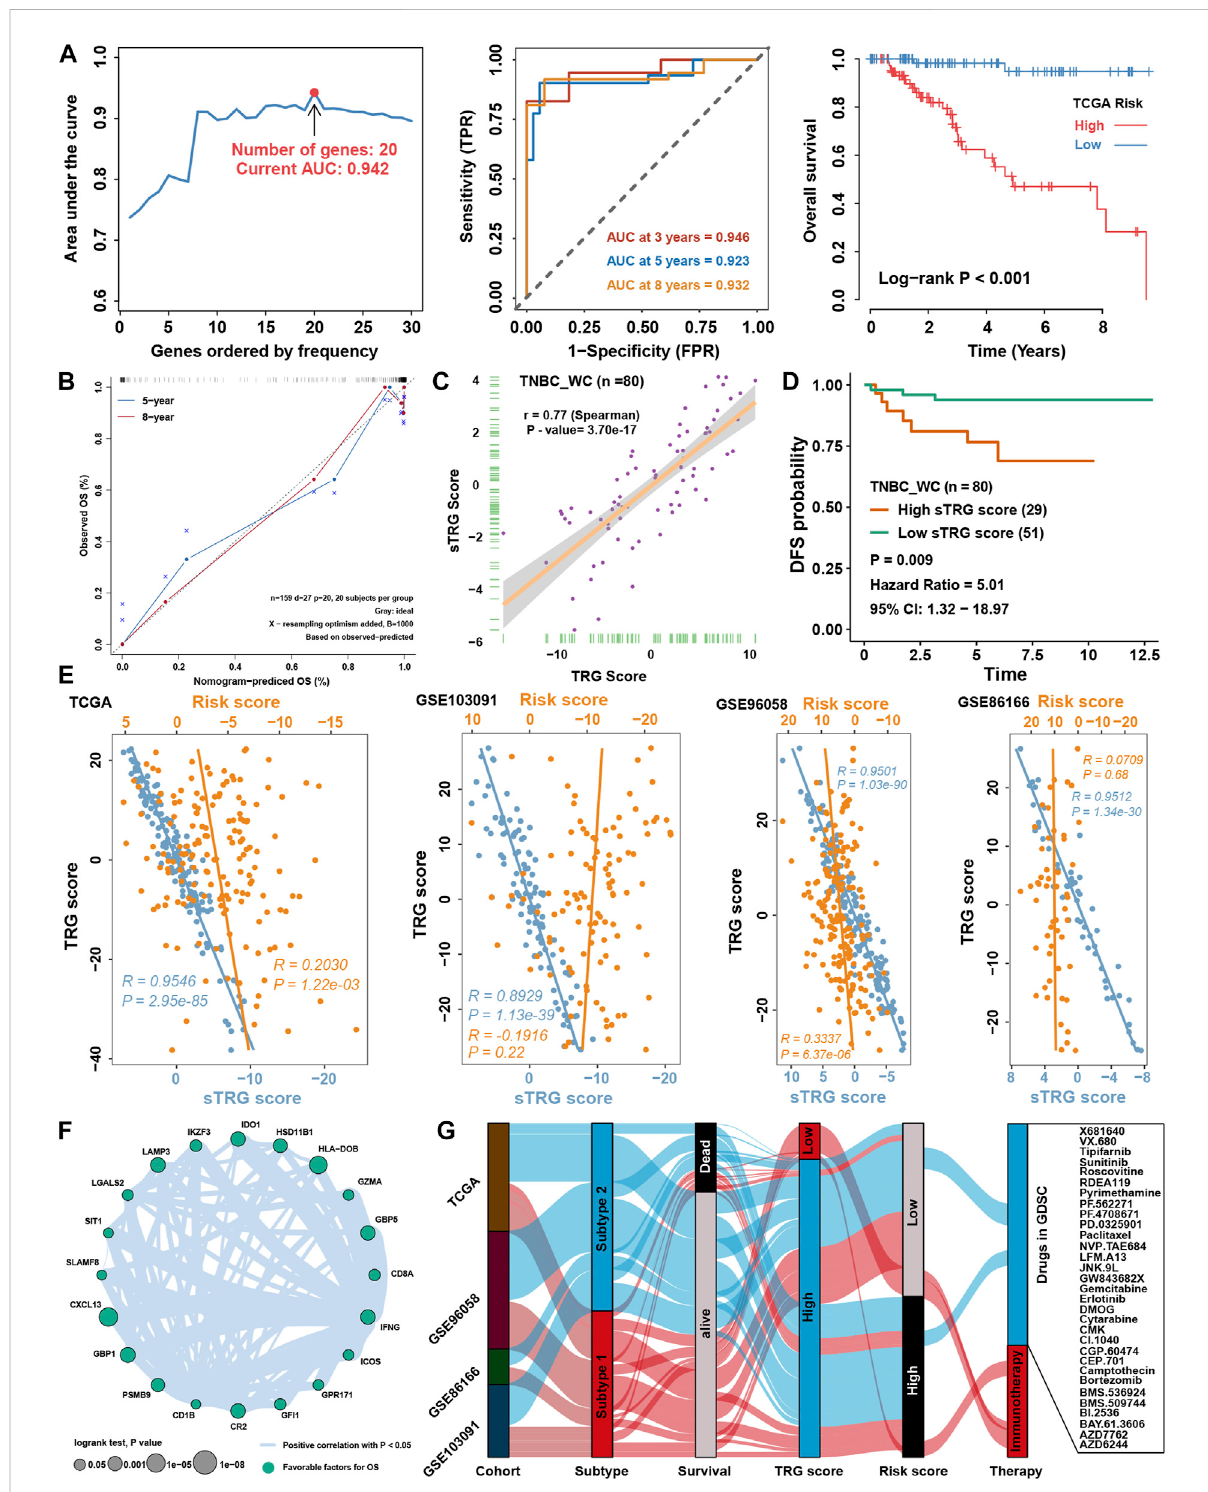
FIGURE 9 Prognostic signature construction and simpli fi cation of the TRG score. (A) Iteration LASSO constructed a prognostic signature with 20 genes. The AUC for 5 years was 0.942, and the survival curve for the risk group is shown in the right panel. (B) Calibration curve for the comprehensive survival nomogram model in theTCGA TNBC cohort. The dashed diagonal line represents the ideal nomogram, and theblue and red lines represent the 5- and 8-year observed nomograms, respectively. (C) Correlation between the sTRG score and TRG score in the TNBC_WC cohort. (D) SurvivalanalysisforthesTRGscoreintheTNBC_WCcohort. (E) CorrelationanalysisbetweentheTRGscoreandsimpli fi edTRG(sTRG)scoreandrisk score infour TNBCcohorts. (F) Correlation network among20genesinvolvedintheprognosticsignature. (G) Alluvial diagramshows thechangesin relationships among multiple groups in our